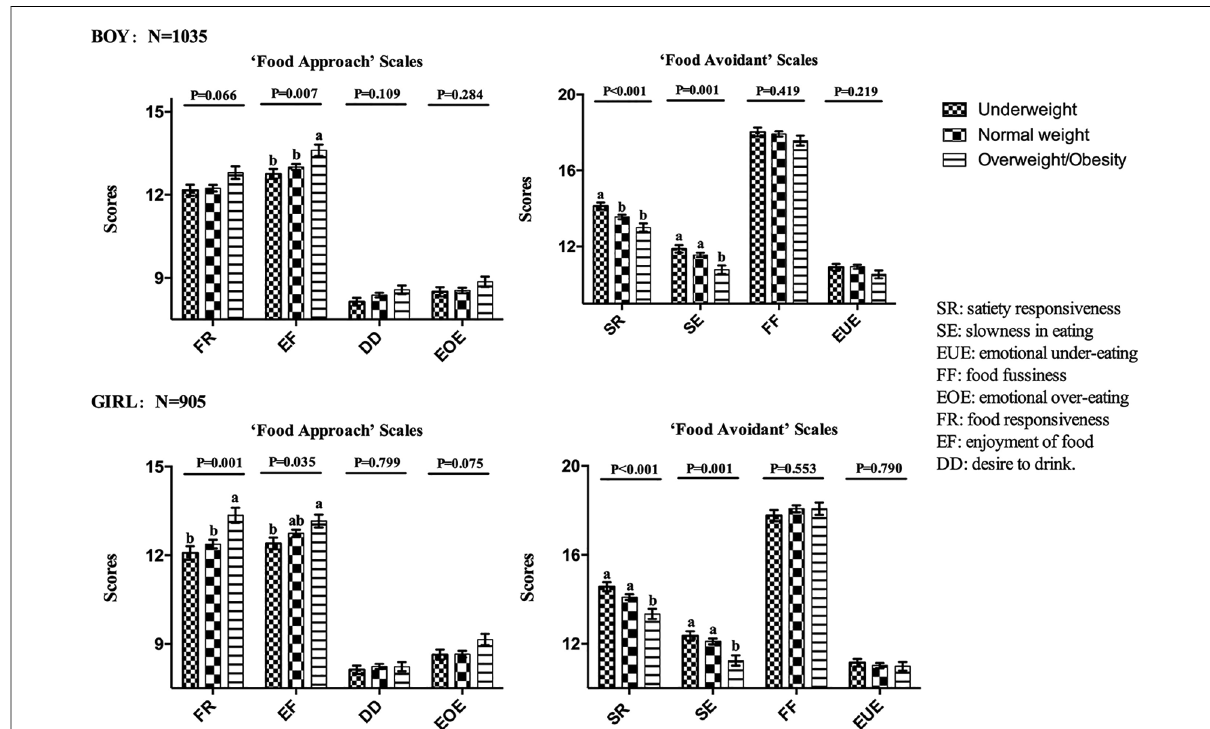
FIGURE 1 CEBQ scores for children with different weight status ( N =1935)